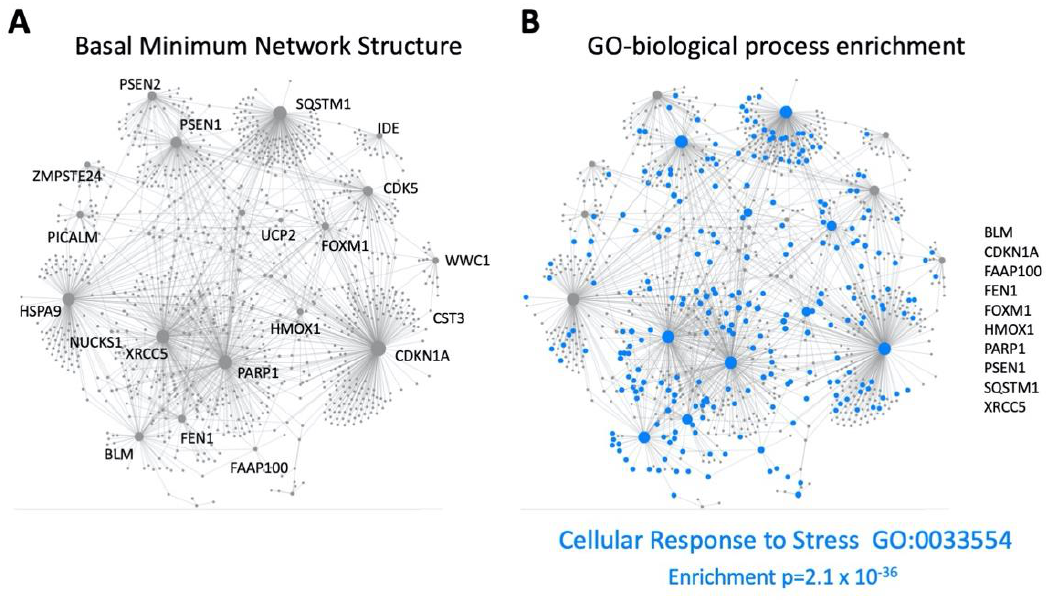
Figure 6. Protein-Protein-Interaction network enrichment. Using the GPR19-Aging specific intersec- tion cohort of 28 proteins, a Basal Minimum interaction network of these 28 proteins, with bridging factors introduced using the IMEx Consortium database, was created using NetworkAnalyst ( A ).